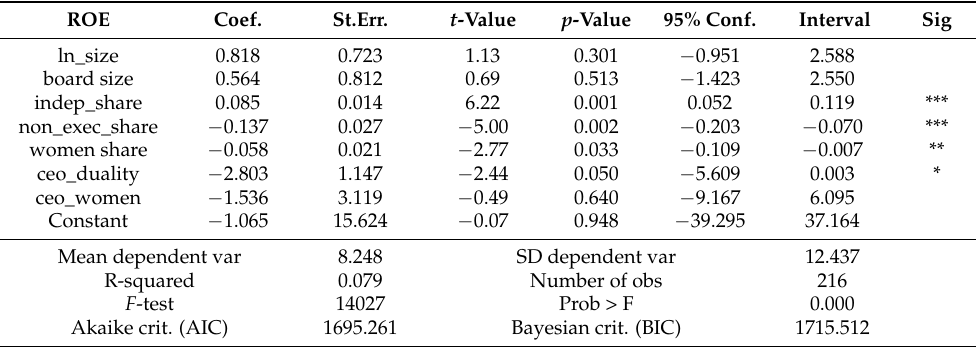
Table 5. OLS Regression Results with Board and CEO Characteristics. ROE